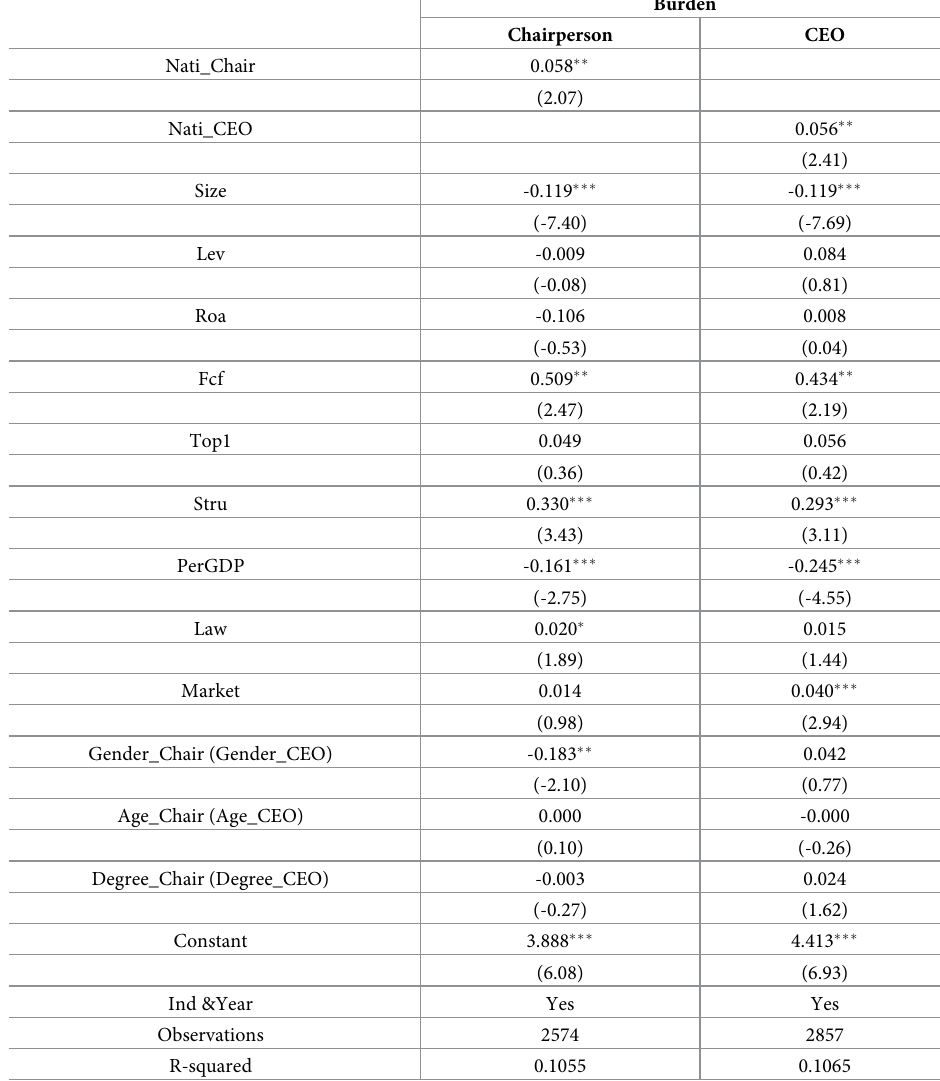
Table 10. Senior executive home bias and employee